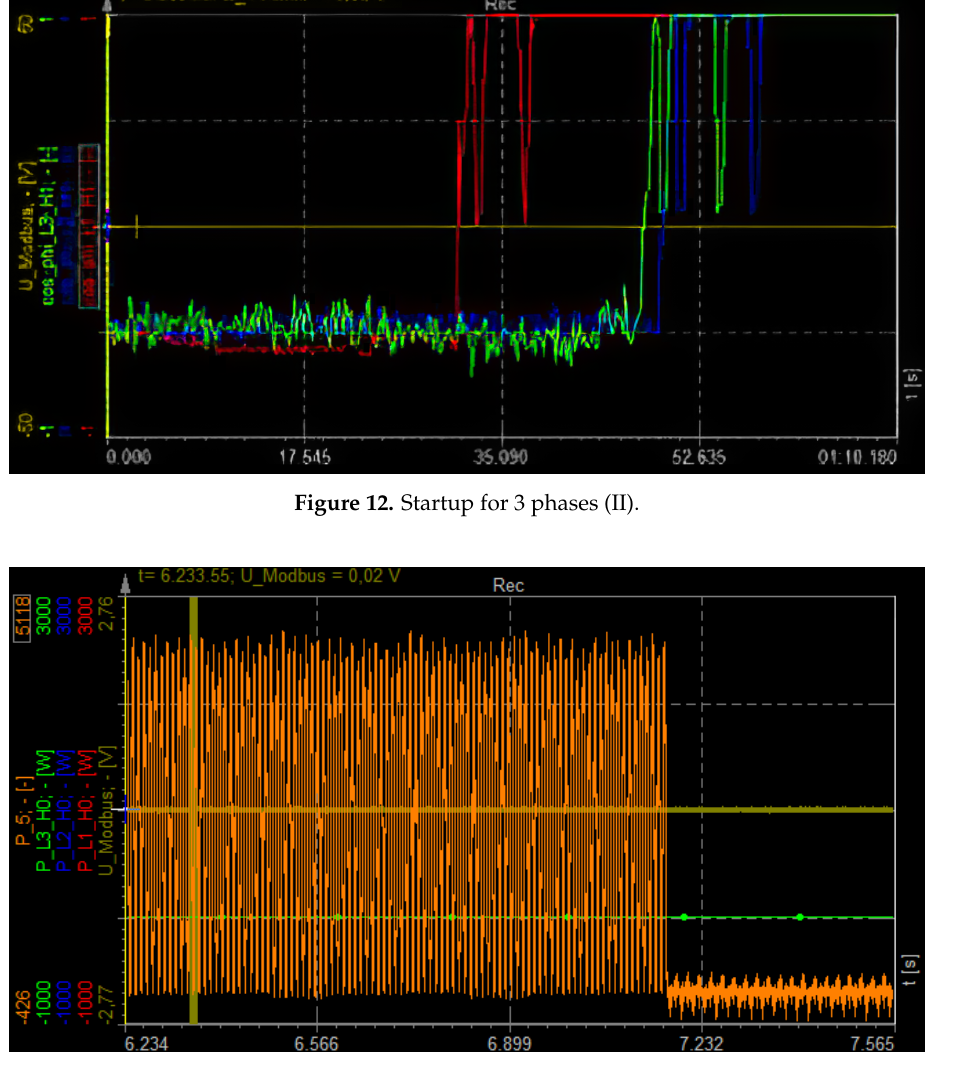
Figure 13. Shutdown